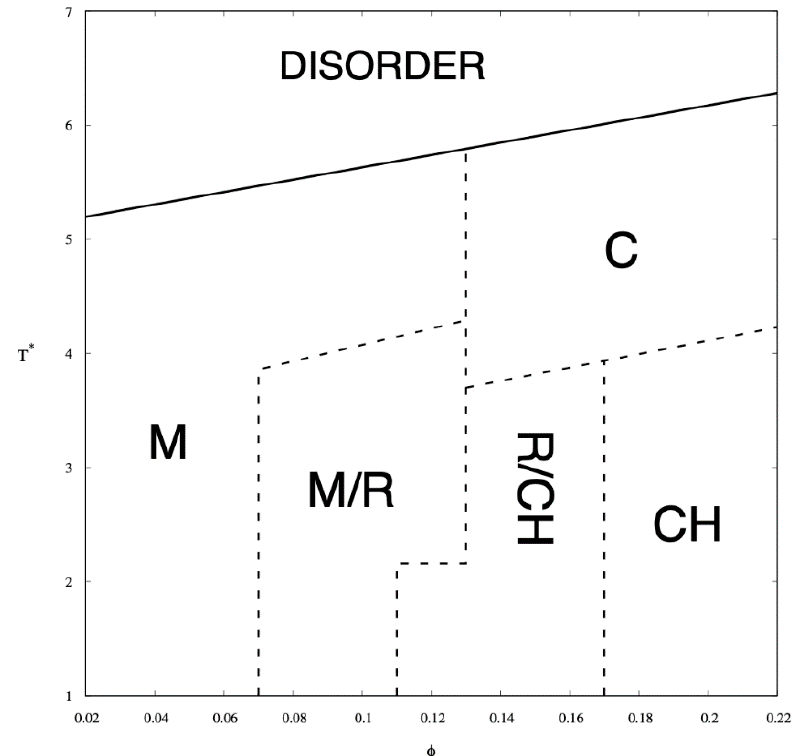
Figure 4. Monte Carlo phase diagram of A8-B2-A6-B2-A8 pentablock colomymer in a selective solvent as a function of the chain volume fraction, ϕ , and the reduced temperature, T*. Solid line is the approximate critical micelle temperature (CMT) / order–disorder transition (ODT) line while the dashed lines indicate transitions between the following arrangements: micellar (M), rod-like elongated micellar (R), 3-dimensional channels (CH), and cylindrical (C).